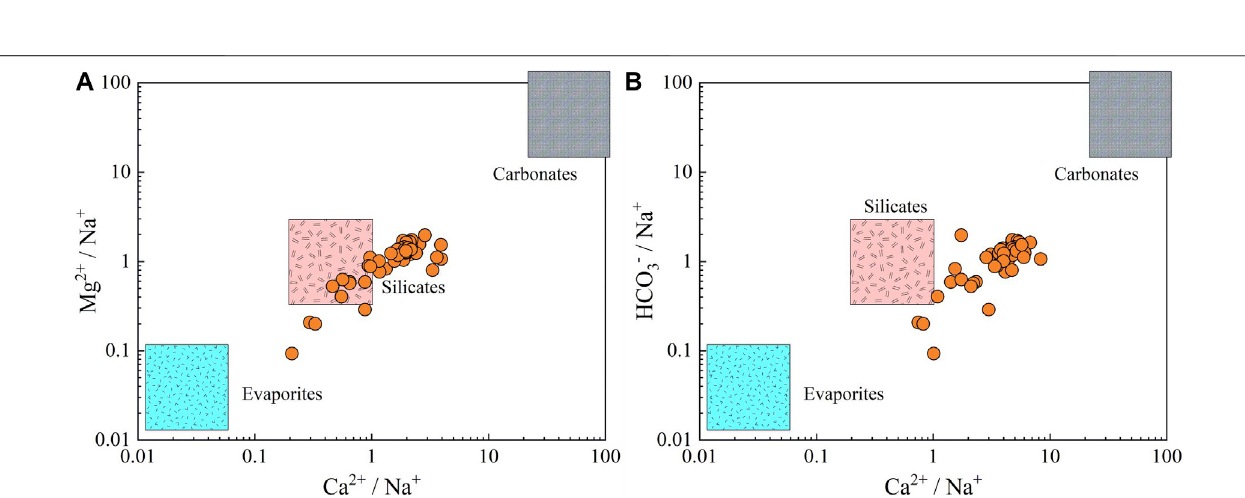
Frontiers in Environmental Science |